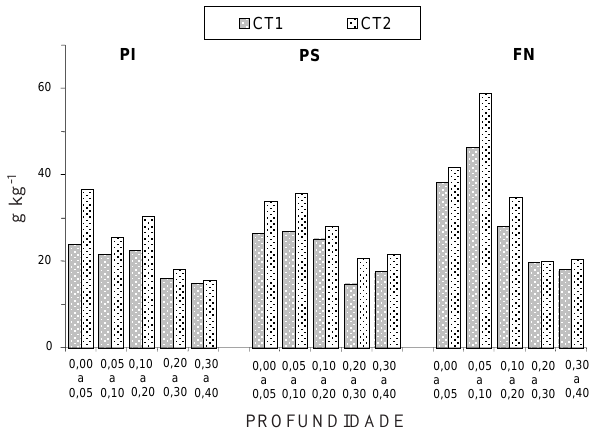
Figura 1. Carbono orgânico total nos agregados maiores e menores que 0,25 mm, respectiva- mente (CT1 e CT2), de solos sob plantio direto irrigado (PI), plantio direto de sequeiro (PS) e floresta nativa (FN), em cinco profundidades.